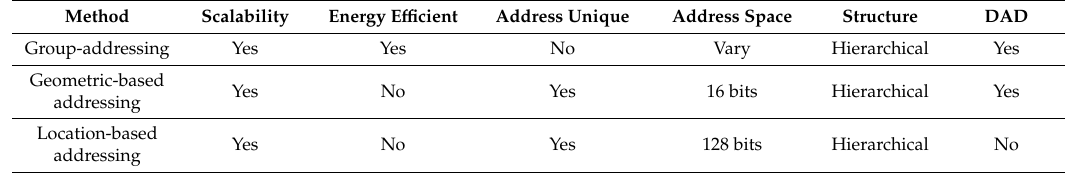
Table 2. Summary of configuration mechanisms with additional information for WSNs.